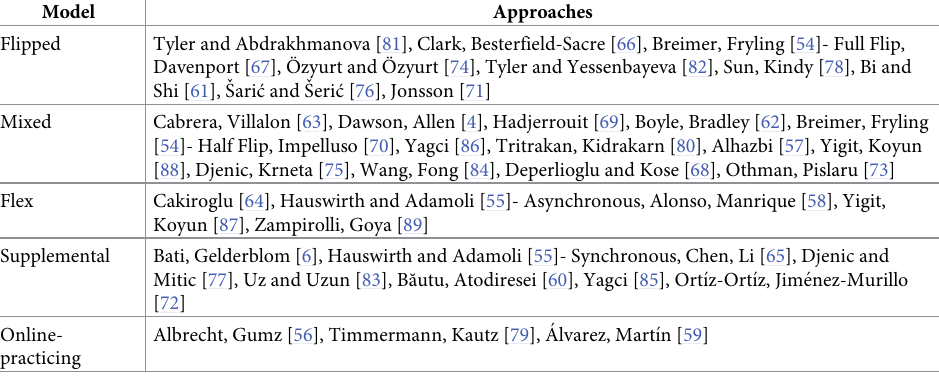
Table 7. Blended learning models and their corresponding